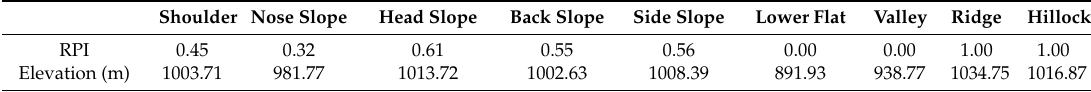
Table 3. Average RPI and elevation for terrain positions.